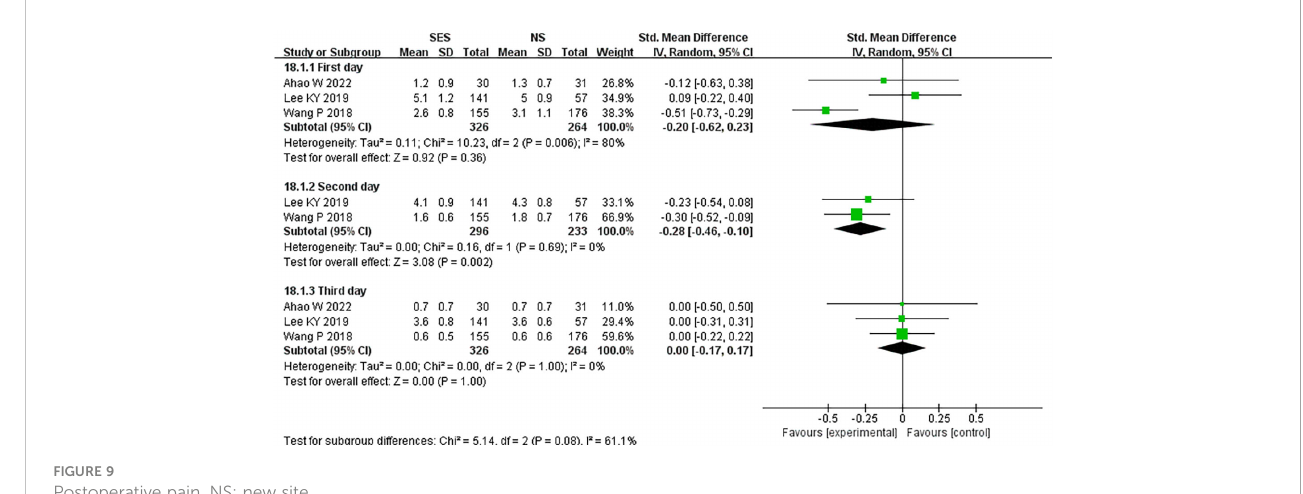
FIGURE 9 Postoperative pain. NS: new